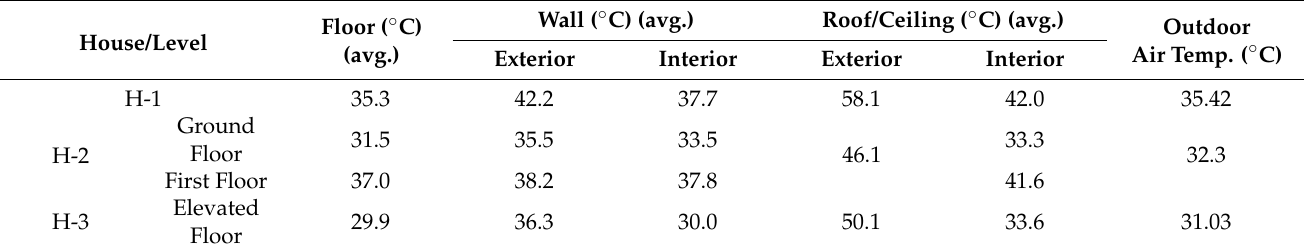
Table 6. Surface temperature (mid-day:12:00 pm–4:00 pm) differences of timber house envelope.